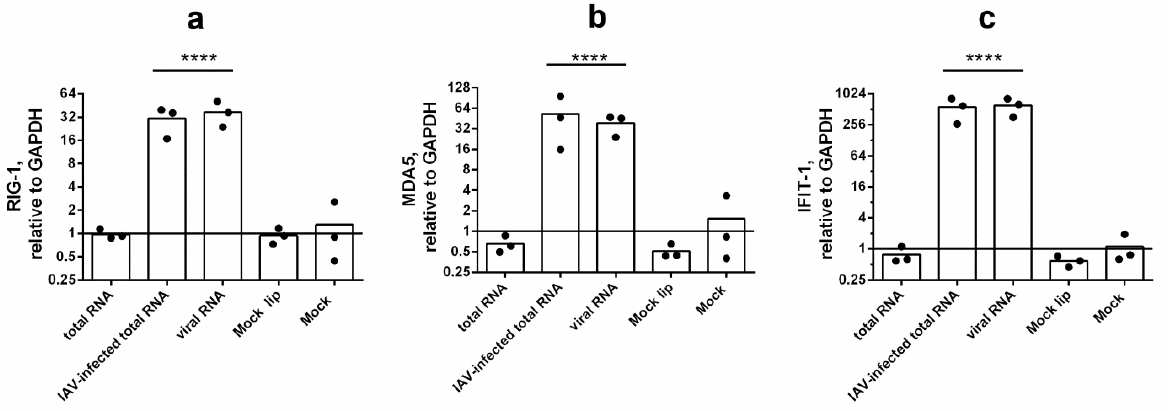
Figure 3. Total RNA from IAV infected cells strongly induces RIG-1 (a), MDA5 (b), and IFIT-1 (c) expression. Expression levels were detected at 24 h post transfection. Gene expression was analyzed via the ∆∆ Ct method (relative to GAPDH). Statistical significance ( p -value) was determined by ordinary one-way ANOVA, followed by Holm–Sidak’s multiple comparisons test: ****—adjusted p Value < 0.0001 compared to Mock. Mock—intact cells that were cultured in the same conditions and were not transfected (instead, sterile medium F12K was added). At least three biological replicates were used for each experimental data point. Data are represented as median.